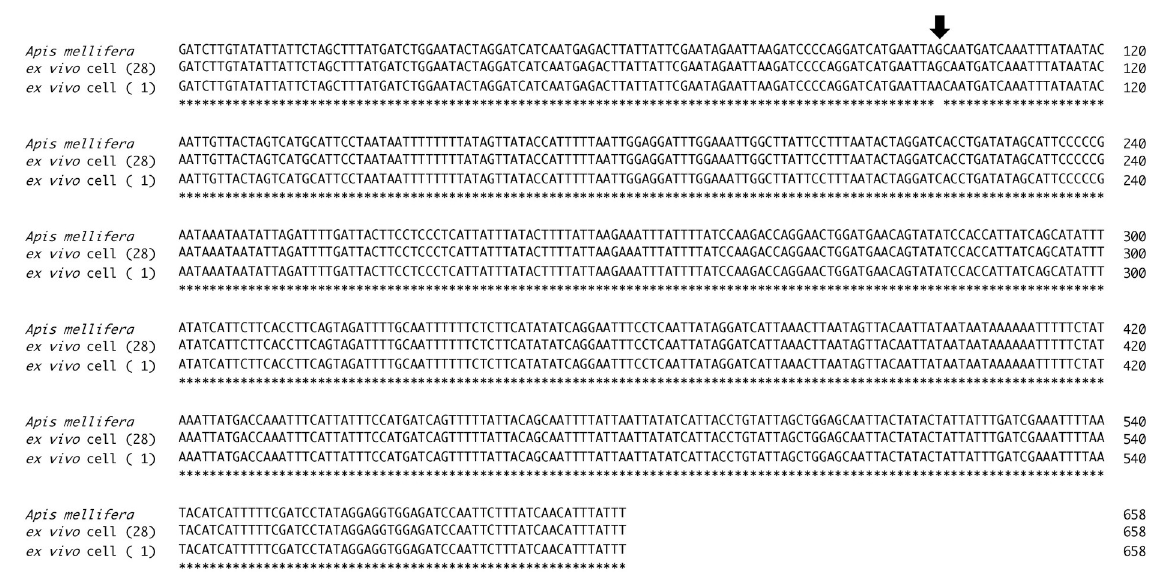
Fig 5. Alignment of nucleotide sequences of the mitochondrial cytochrome c oxidase subunit I ( COI ) gene. A partial sequence of the Apis mellifera COI gene (658 bp excluding the primer sites) is shown on the top. Twenty-eight out of the 29 clones obtained from ex vivo cultured cells had the same sequences to A . mellifera COI (middle line). One clone (bottom line) had a single base substitution (arrow). Asterisks indicate identical